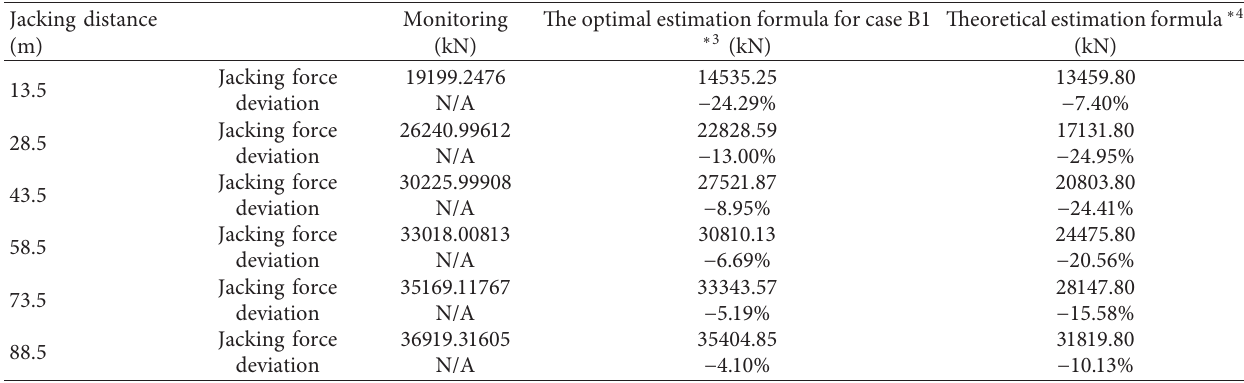
Jacking distance (m)